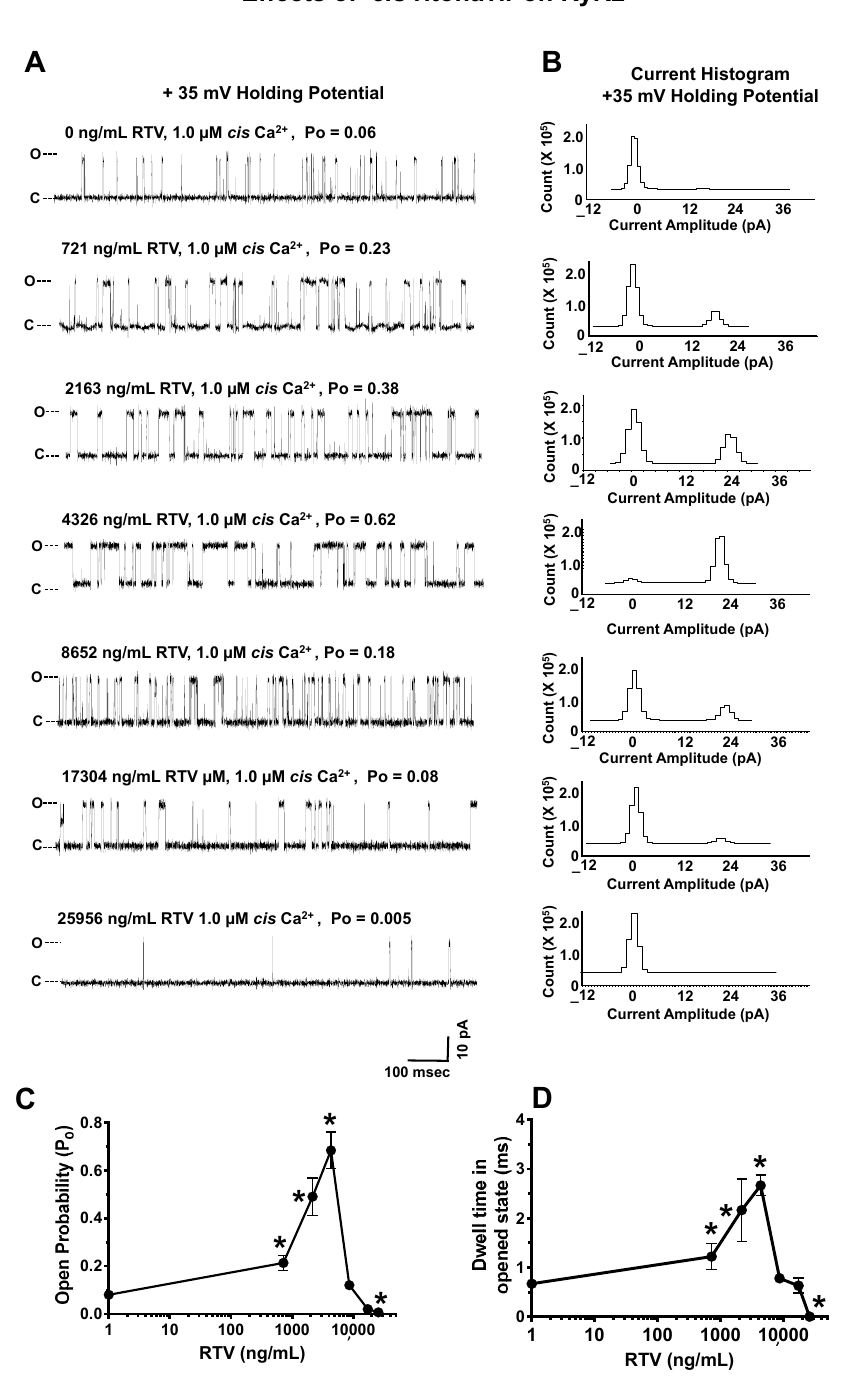
Figure 5. Effects of increasing cis concentrations of ritonavir (RTV) on the open probability of RyR2. Panel A shows a representative 1.0 s recording of a RyR2 channel with 1.0 µ M cis Ca 2+ and cumulative amounts of cis RTV; Panel B shows the current histograms for the channel with cumulative amounts of cis EFV. Panels C , D are graphs of the open probability and dwell time (mean ± SD) of RyR2 as a function of the cis concentrations of the RTV channels for n = 11 channels. Recordings shown are at +35 mV (upward deflections) in a symmetric KCl buffer solution (0.25 mM KCl; 20 mM K/HEPES; pH 7.4). O, open; C, closed. * denotes significantly different ( p < 0.05) from the control (before the addition of the